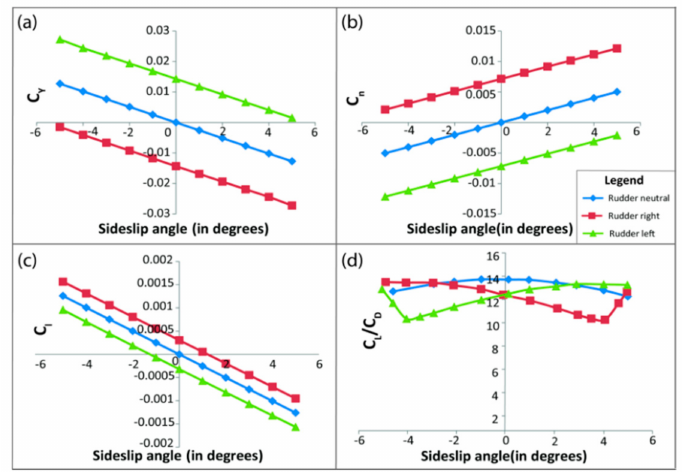
Figure 13. Change in aerodynamic parameters due to rudder deflection. Here, subfigure ( a ) shows the variation of C Y (coefficient of side force), ( b ) shows the variation of C n (coefficient of yawing moment), ( c ) shows the variation of C l (coefficient of rolling moment), and ( d ) shows the variation of C L /C D with varying sideslip angles and a fixed rudder deflection of 10 ◦